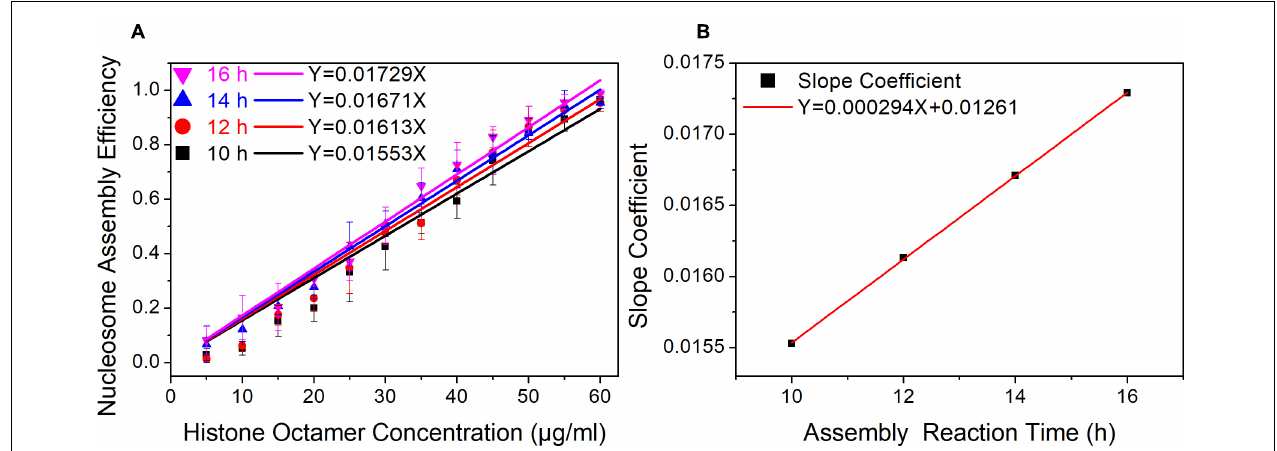
FIGURE 3 | The regression curve of nucleosome assembly efficiency vs. reaction time for 601 DNA sequence under different assembly reaction times. (A) Regression curves of nucleosome assembly efficiency vs. histone octamer concentration under 10, 12, 14, and 16 h of dialysis time. For each sample, five independent repeats were performed. (B) Linear regression curve between the slope coefficient in panel (A) and assembly reaction